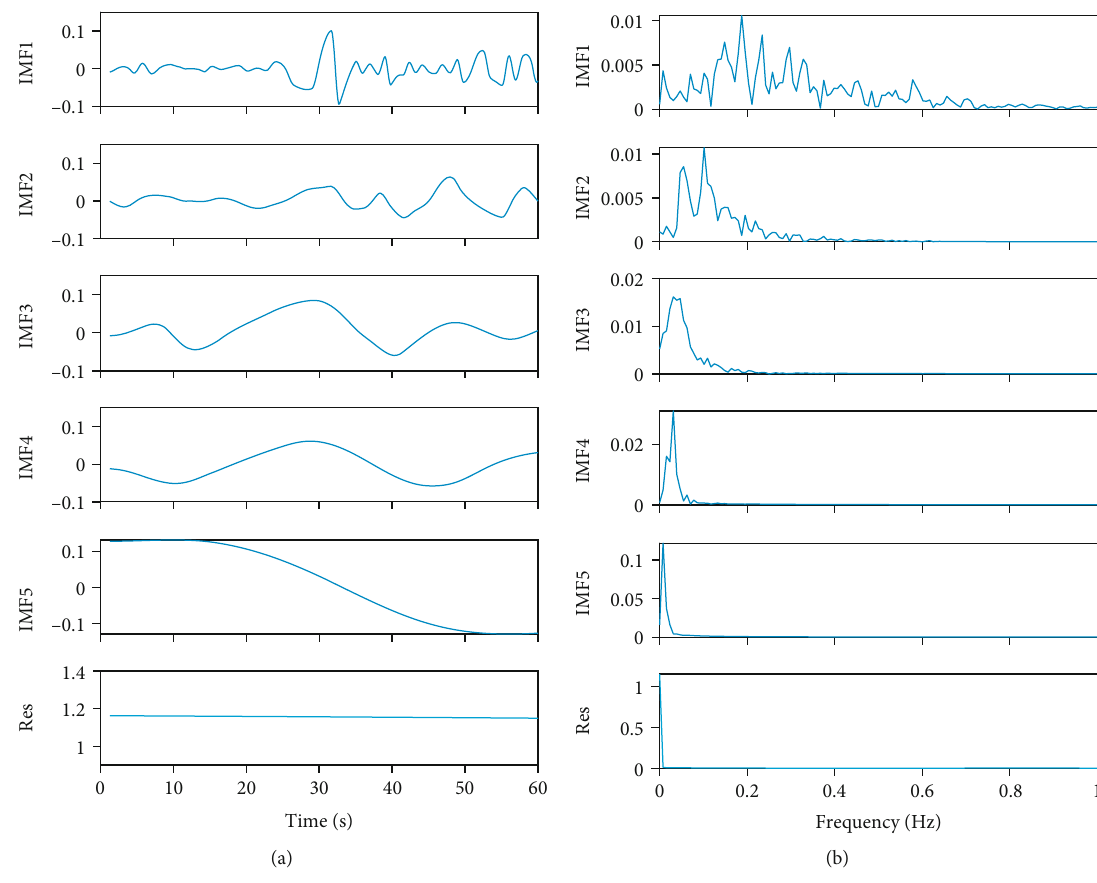
Figure 1: (a) The IMF components of the RR intervals. (b) Spectrum analysis on each IMF.